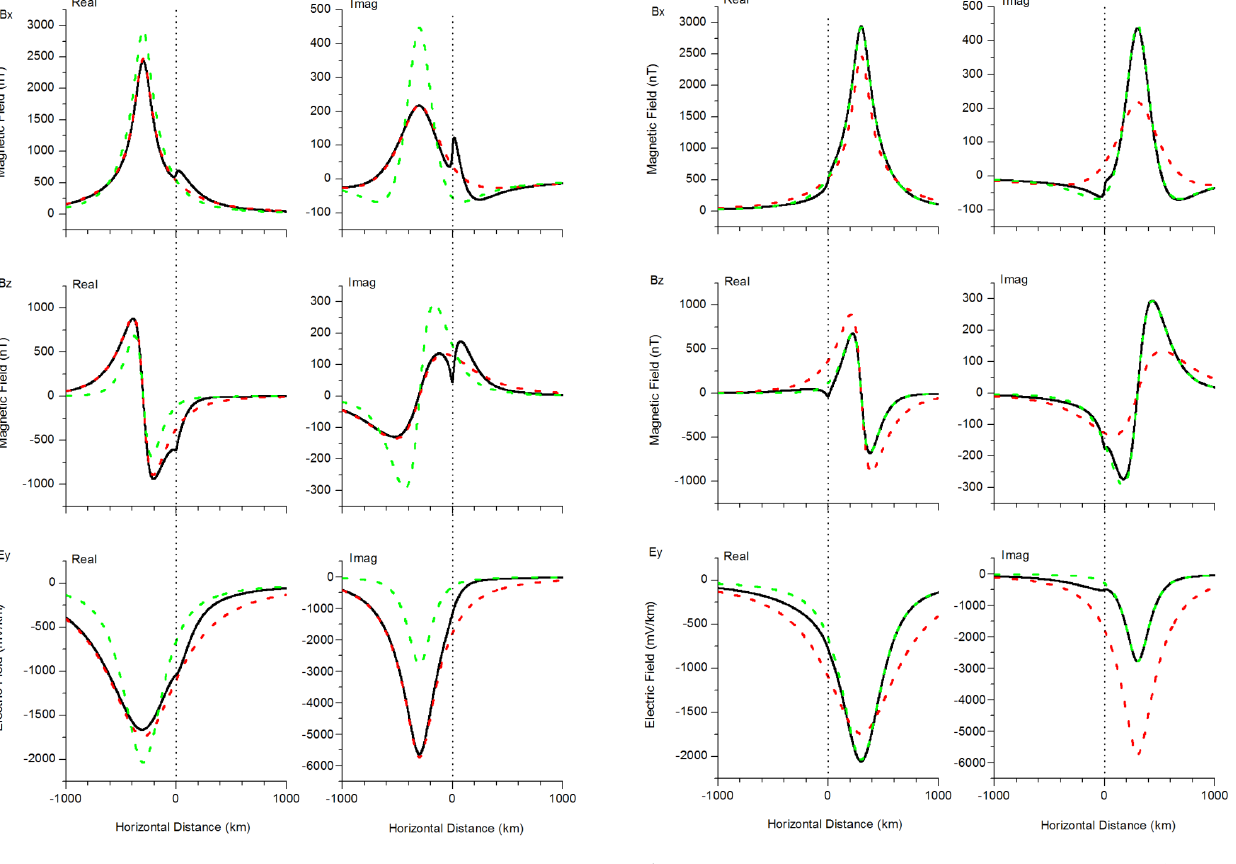
Fig. 10. Same as Fig. 9 but the line current is displaced from the interface region to x = -2 300km.